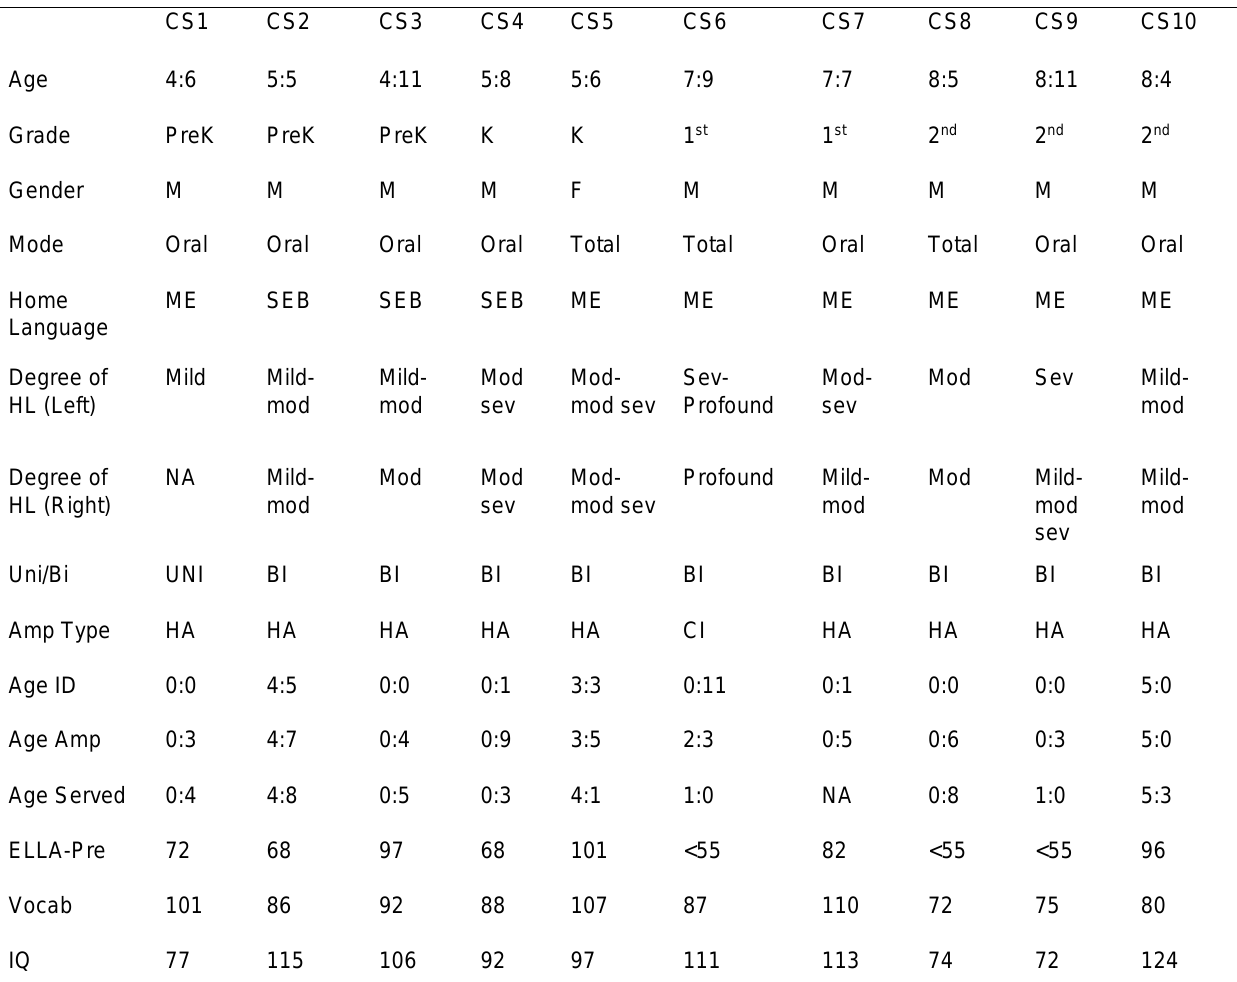
Table 2. Profiles for In-person Group Participants